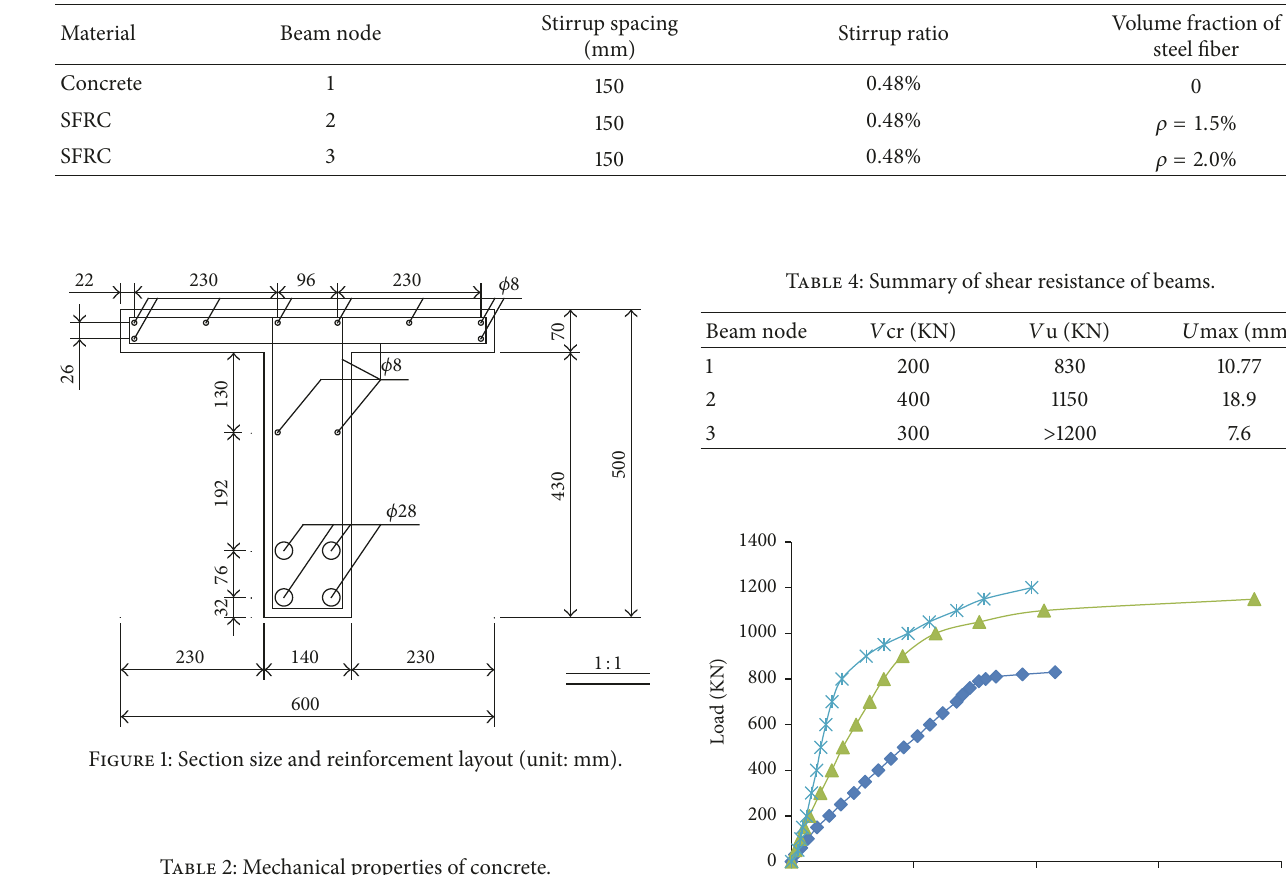
Table 2: Mechanical properties of concrete.